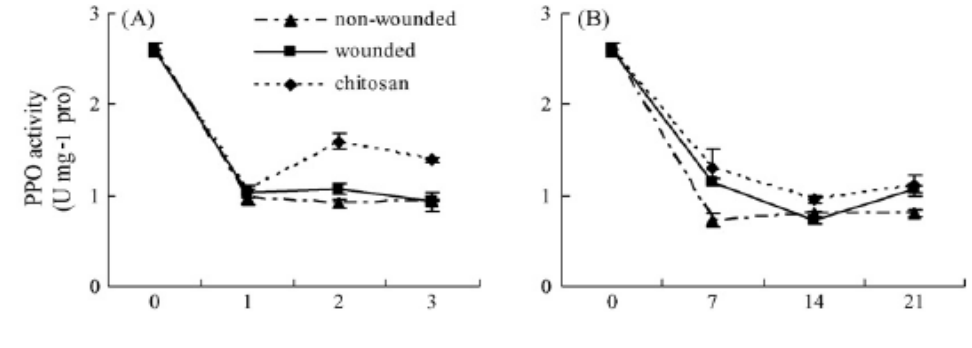
Figure 12. Changes of PPO activities ( A and B ), POD activities ( C and D ), and phenolic compounds ( E and F ) in tomato fruit. Fruit were treated with 1% chitosan, and stored at 25 °C ( A , C and E ) and 2 °C ( B , D and F ), respectively. Fruit wounded and treated with water, and non-wounded, served as controls. Bars represent standard deviations of the means. Reproduced from Reference